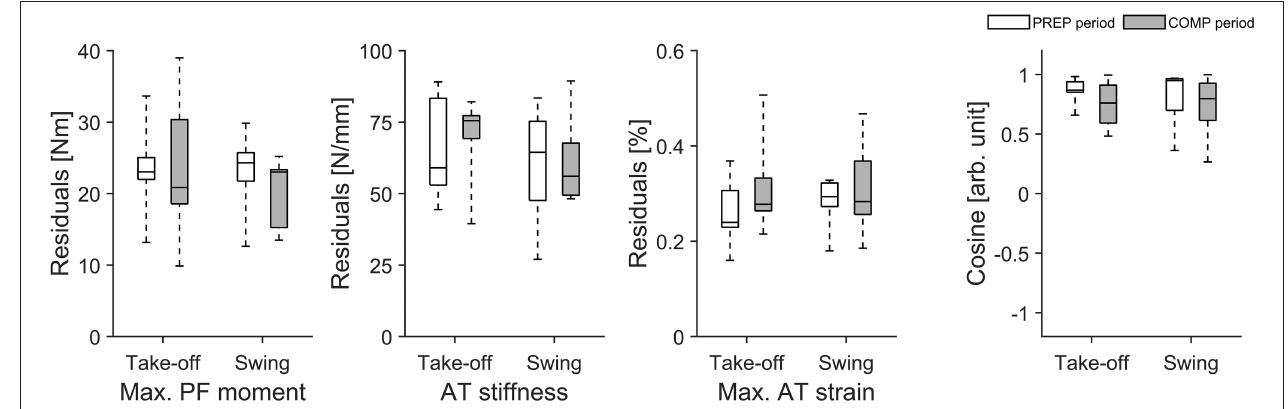
FIGURE 4 | Box plots of residuals in muscle strength (Max. PF moment), tendon stiffness (AT stiffness) and maximal tendon strain (Max. AT strain) as well as in cosine similarity (Cosine) of the relative changes of muscle strength and tendon stiffness between sessions over 4 years during preparation (PREP) and competition (COMP) period in six elite jumpers (take-off and swing leg).